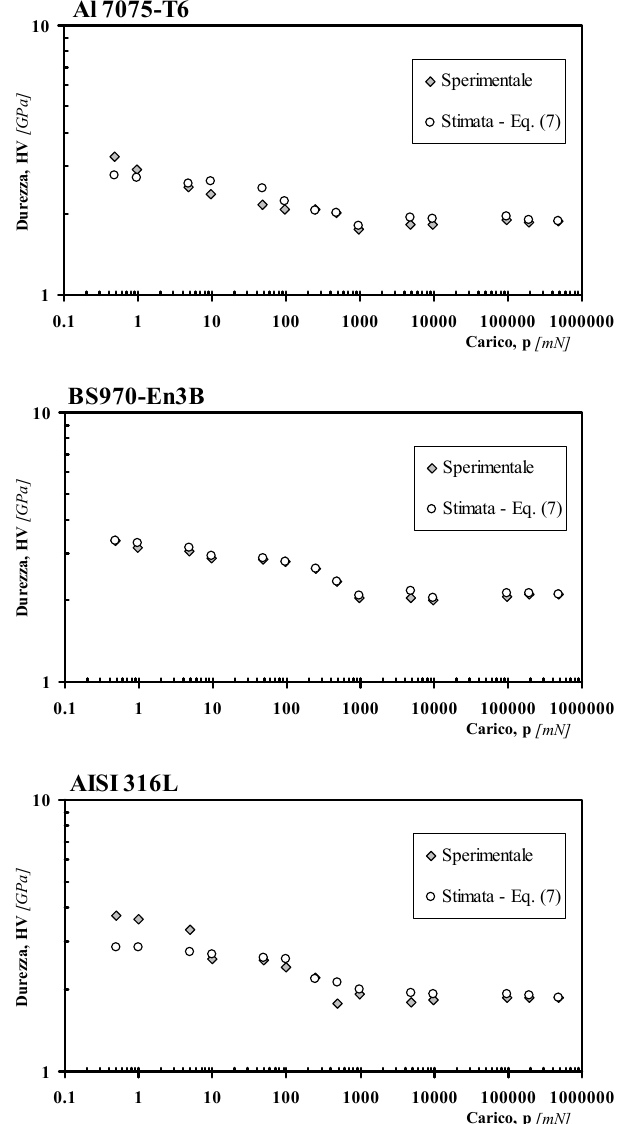
Figura 8: Comparazione tra risultati sperimentali e stime FEM corrette a mezzo della metodologia proposta. Figure 8: Comparison between experimental results and predictions made by correcting the calculated FE values according to the proposed engineering